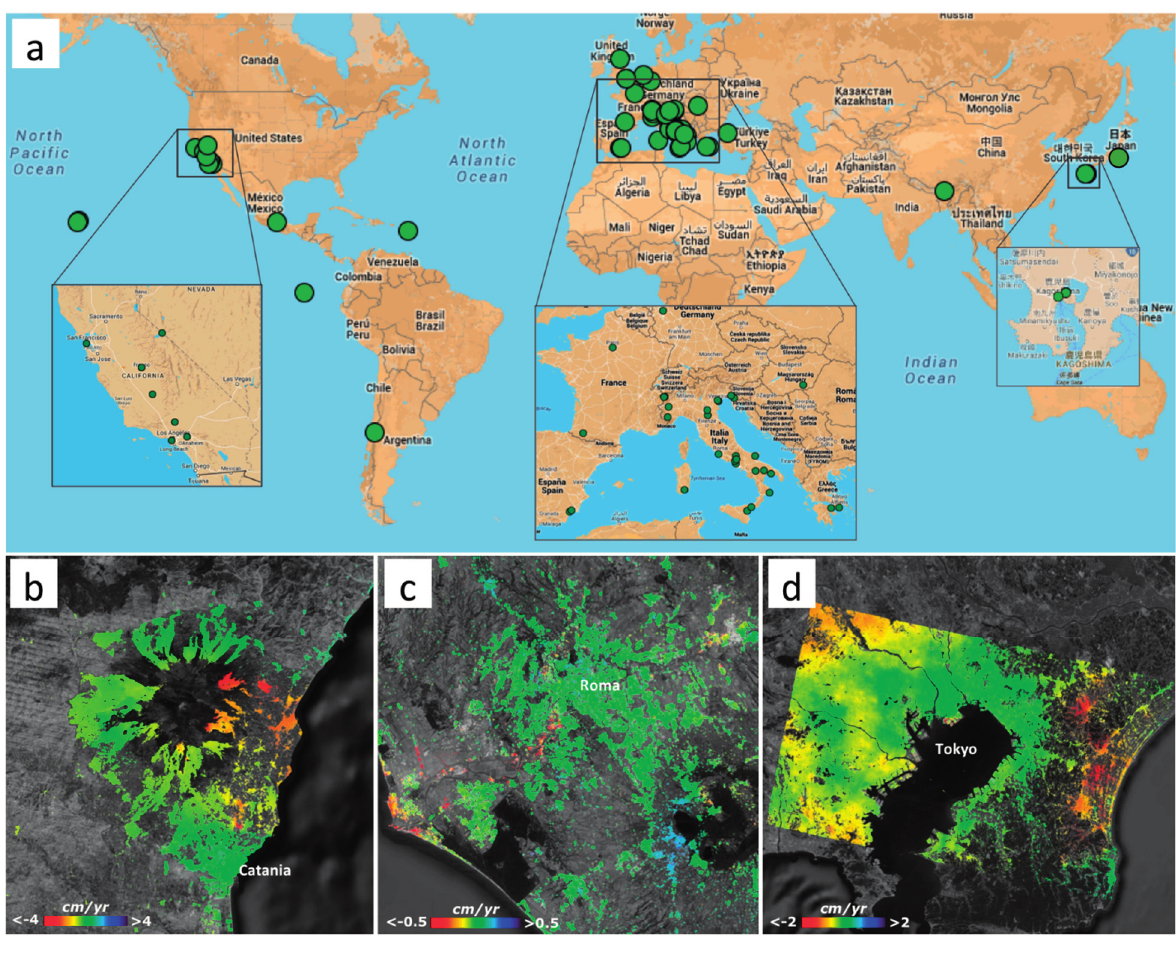
Figure 3. P-SBAS processing status. ( a ) Pictorial representation of the processing results achieved by the users through the P-SBAS web tool within G-POD, during the 6-month period January–June 2015, ( b ), ( c ), and ( d ) are the retrieved mean deformation velocity